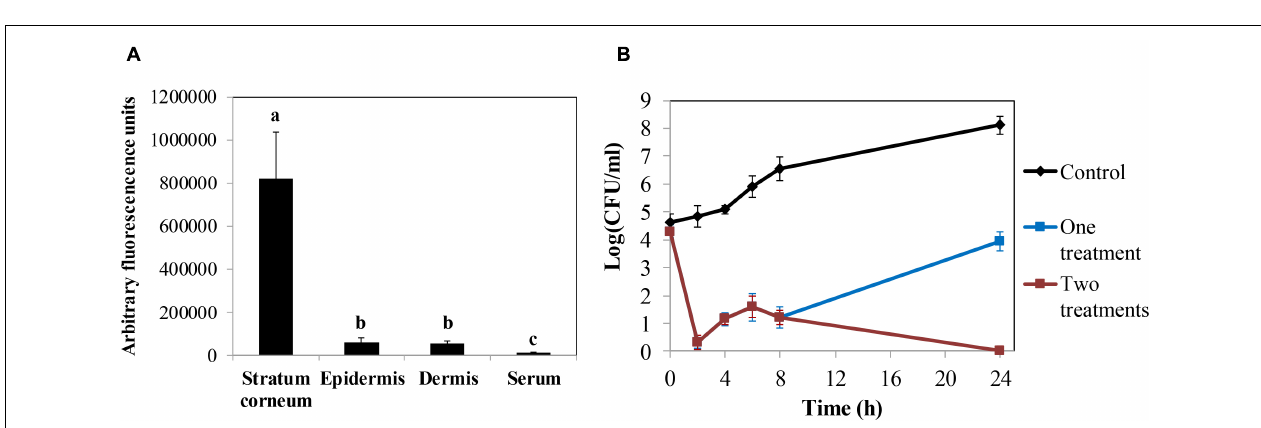
FIGURE 3 | In vitro model of HaCaT cell line colonization by S. aureus 15981. (A) No wound damaged cell line; (B) wound damaged cell line. Variation in the normalized cell index (CI) of HaCaT monolayers contaminated with S. aureus 15981 (10 6 CFU/well) for 3 h and treated with 0.7 µ M of LysRODI (cid:49) Ami. Data normalization was performed as follows: the normalized-CI at a given time point was calculated by dividing the CI at this point by the CI at the normalization time point which, in our case, was the first time monitored immediately after protein addition (10 min). Thus, at the normalization time-point the normalized-CI equals 1 for all wells. The red, black, and blue lines represent the HaCaT cell line without bacteria, the infected cell line and the infected cell line treated with the protein, respectively. Values represent average ± SD of three replicates.